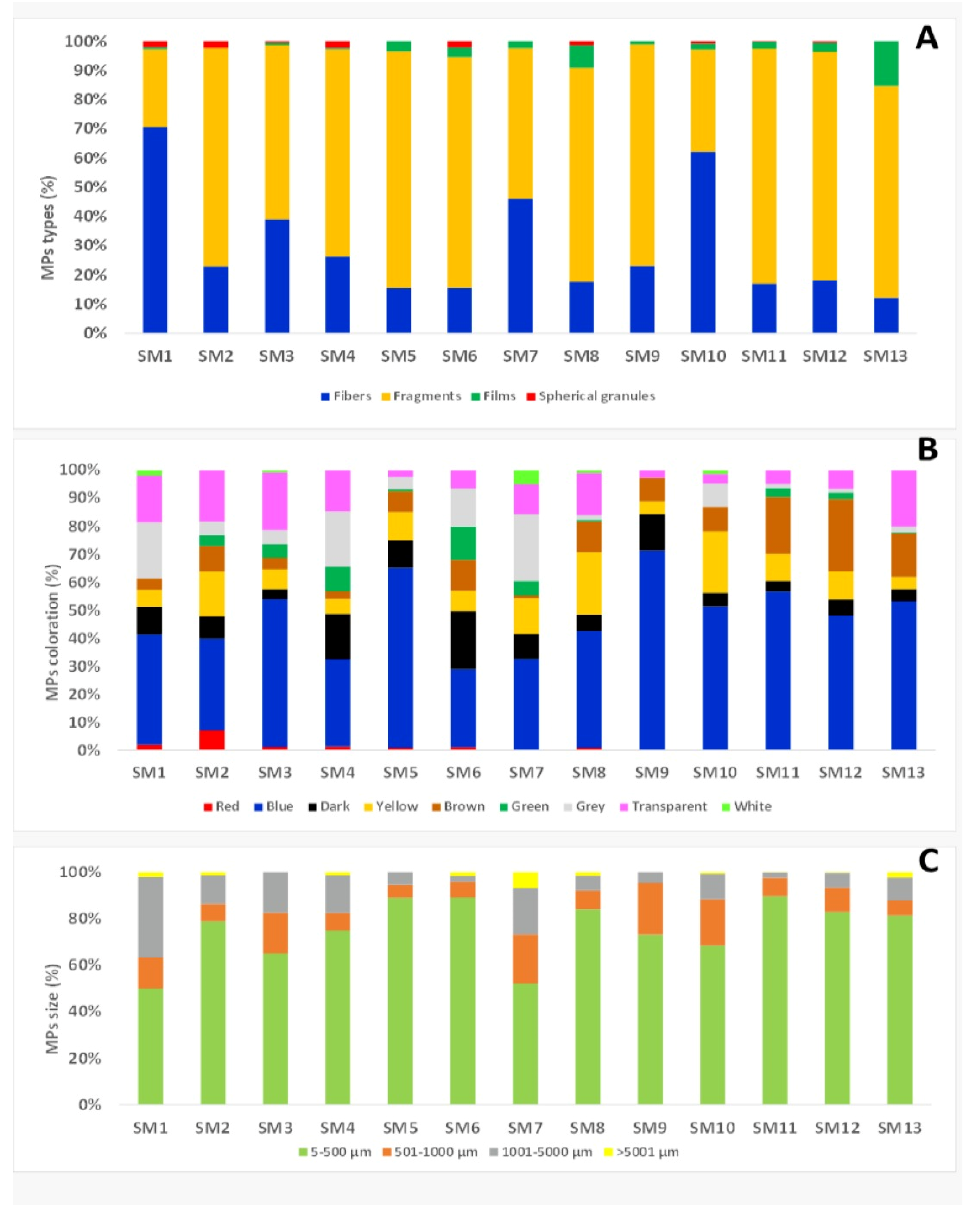
Figure 1. distribution by type ( A ), colour ( B ) and size categories ( C ) of MPs in mussel samples.